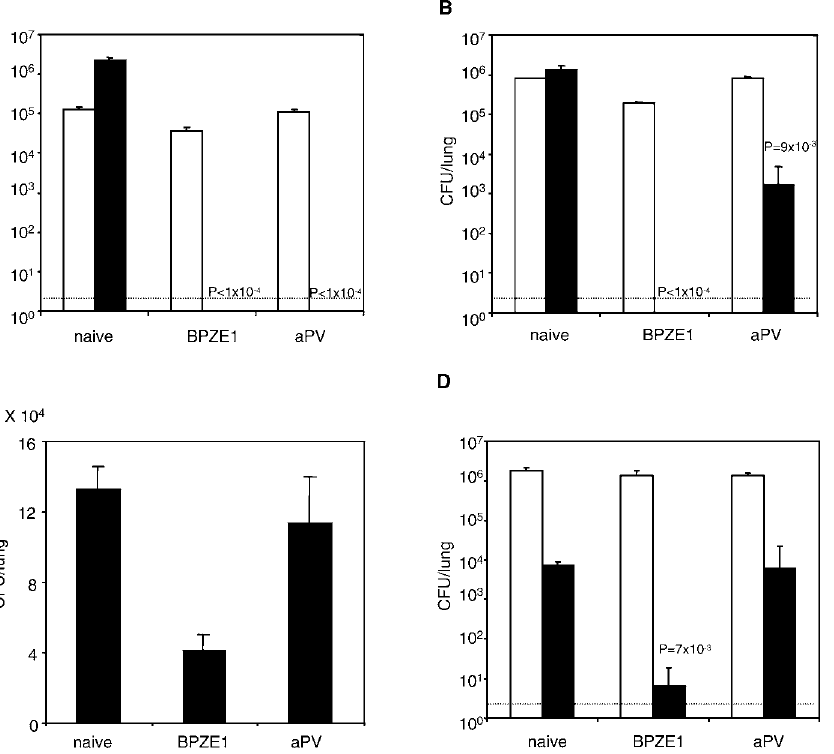
Figure 4. Protection against Bordetella Infection Protection against B. pertussis in adult (A) and infant mice (B) and (C), or against B. parapertussis in infant mice (D). Mice immunized with BPZE1, aPV, or PBS (naive) were challenged with BPSM (A), (B), and (C), or B. parapertussis (D), and lung CFU counts were determined 3 h (open columns) or 7 d (filled columns) later. Results are expressed as mean ( 6 standard error) CFUs from three to four mice per group and are representative of two separate experiments. (C) CFU counts 3 h after BPSM challenge in adult mice vaccinated with BPZE1 or aPV, compared to controls. The dashed lines in panels (A), (B), and (D) represent the limit of bacterial counts. DOI: 10.1371/journal.ppat.0020065.g004